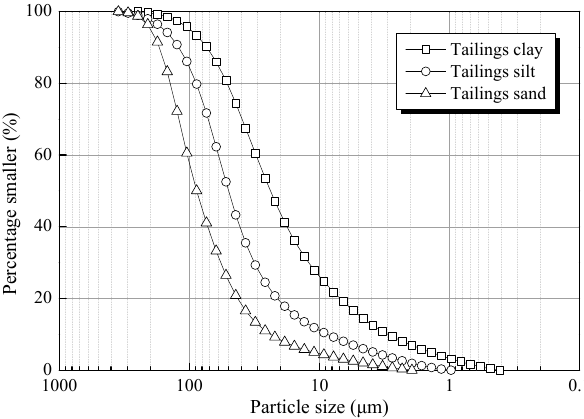
Figure 2. Particle size distribution of the tailings samples.